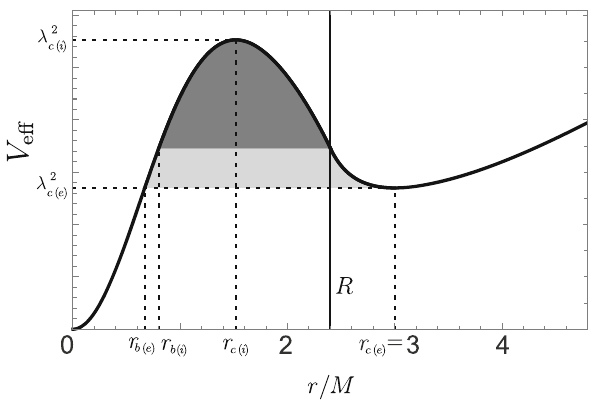
Fig. 1 The effective potential for an object with R = 2 . 4 M ; the trapped areas are shaded. The darkly-shaded area, bounded by the radii r b ( i ) and R ,containsnullgeodesicstrappedcompletelyinsidetheobject, while the lightly-shaded area, bounded by the radii r b ( e ) and r c ( e ) , con- tains null geodesics, which can temporarily pass through the surface into the vacuum before returning